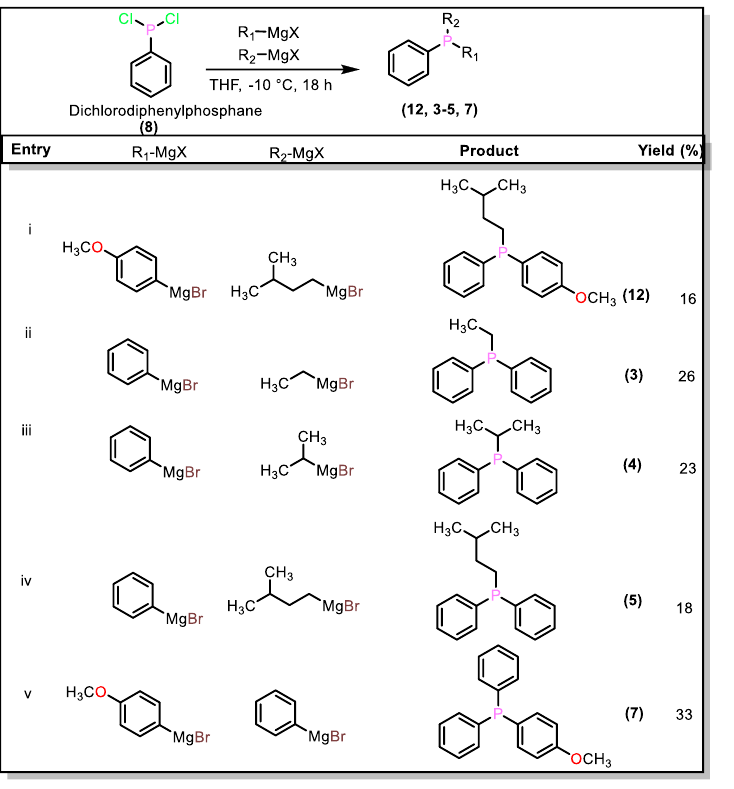
Figure 3. One-pot synthesis of mixed arylalkyl and triaryl phosphines.